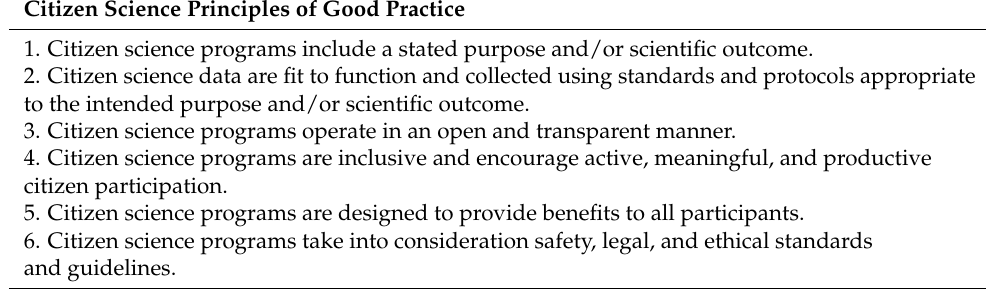
Table 1. Six principles of good practice for citizen science